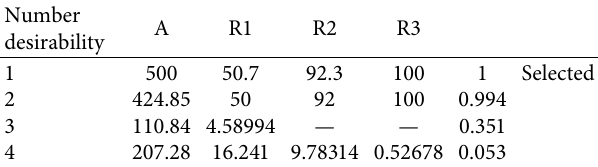
Table 6: Optimum model results using DOE.